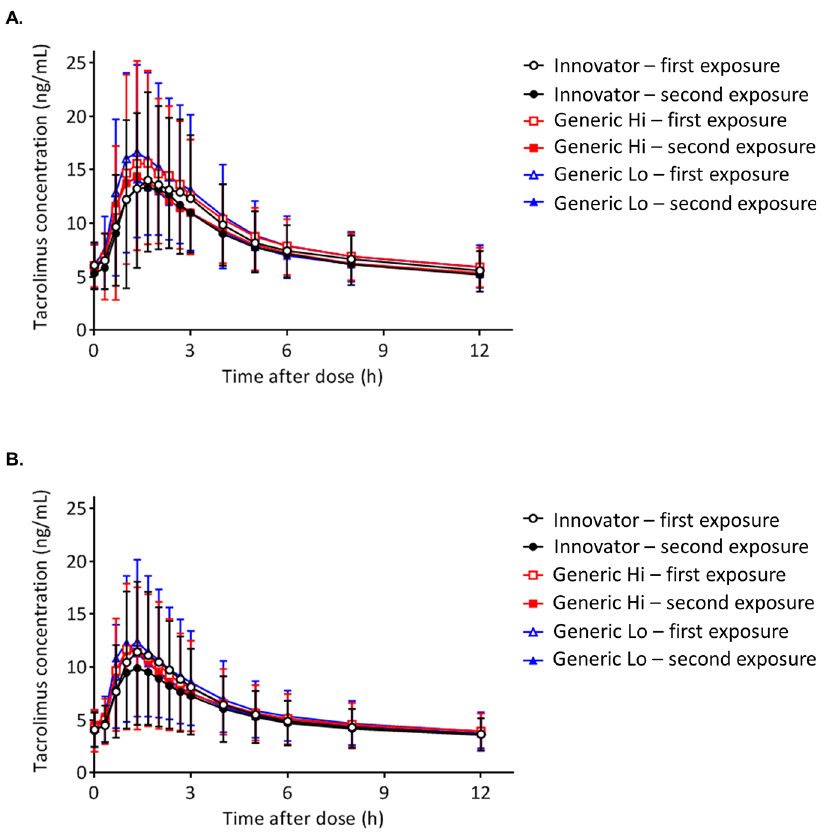
Fig 3. Comparison of tacrolimus time concentration curves by product. (A) Individuals with a kidney transplant. (B) Individuals with a liver transplant. Fifteen tacrolimusblood samples were collectedat C 0 (before the morningdose) and at 20, 40, 60 (1 hour), 80, 100, 120 (2 hours), 140, 160, and 180 (3 hours) minutes and 4, 5, 6, 8, and 12 hours to construct the tacrolimusconcentration-time curves. Each tacrolimus product—Innovator, Generic Hi, and Generic Lo—was administered accordingto the randomly assigned treatment sequence(Fig 1) twice for 1 week before collectionof steady-state pharmacokinetic profiles. Each point on the curve displaysthe tacrolimusmean wholeblood concentrations; standard deviations are depicted by error bars. There were no statistically significantdifferencesbetweenany time points.